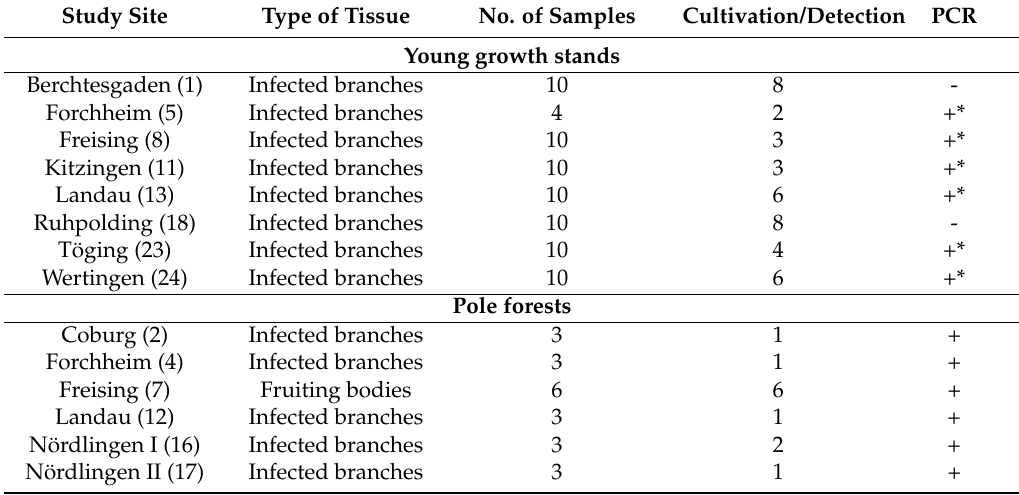
Table 3. Detection of H. fraxineus in the study sites, plot number indicated in